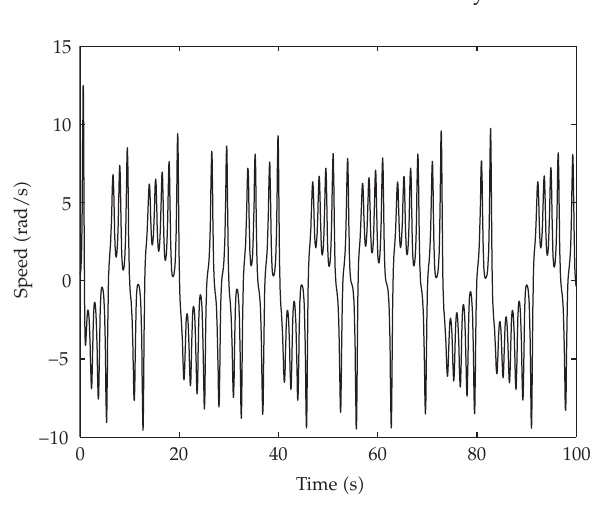
Figure 2: The ω curve of the chaotic PMSM drive system without u d